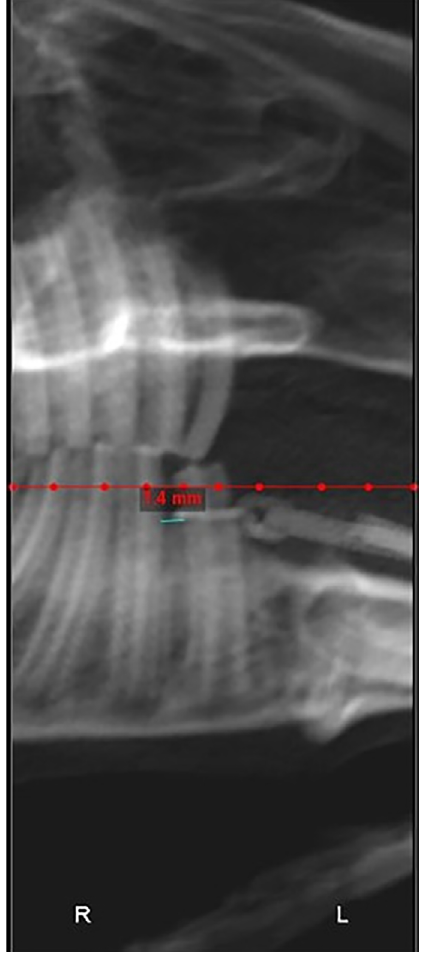
Figure 2- Computed tomography imaging for tooth movement distance